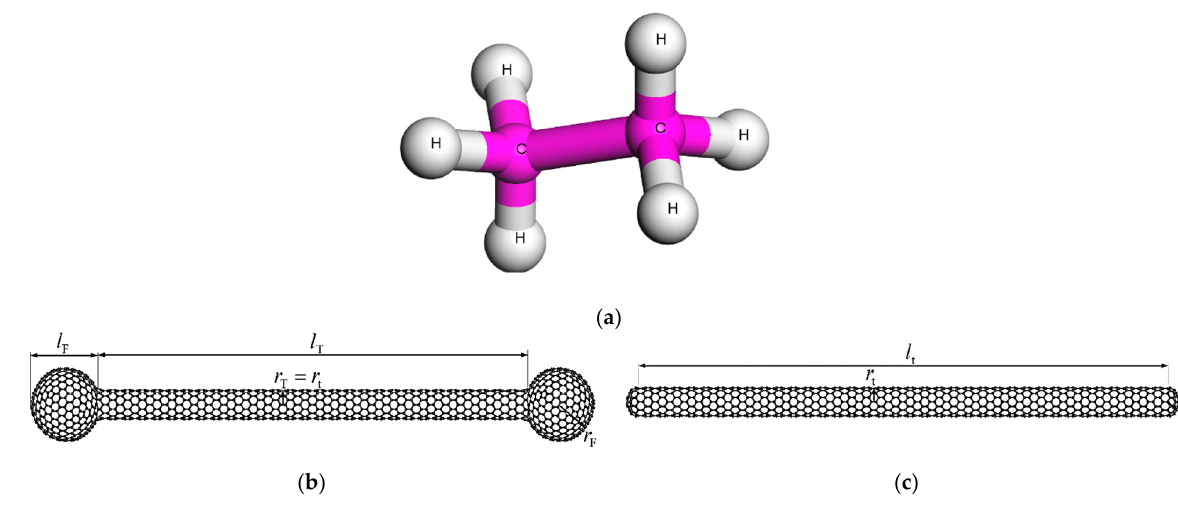
Figure 1. Atomistic structure of the: ( a ) repeat unit of the PE chain, ( b ) BS SWCNT, and ( c ) OC SWCNT.